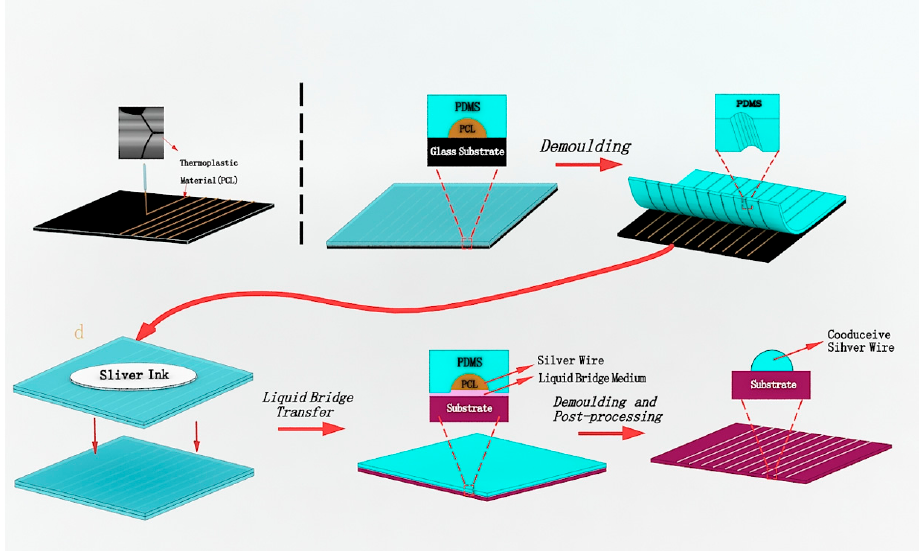
Figure 10. The schematic diagram for the fabrication of the TCE.